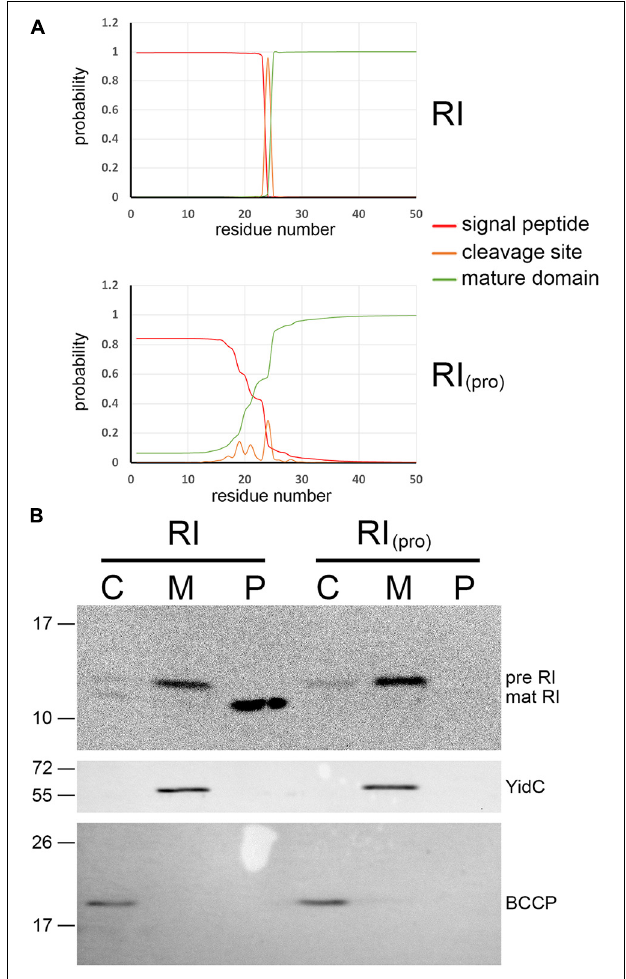
FIGURE 1 | The N-terminal domain of T4 antiholin RI constitutes a signal peptide with an expected signal peptidase cleavage site. (A) SignalP comparison of signal peptide from pinholin-associated endolysin P1 (the first identified SAR domain; Xu et al., 2004) with the signal peptide of the T4 antiholin RI. Note the distinct cleavage site likelihood. For more comparisons, see Supplementary Figure 1 . (B) Transport analysis of RI and a RIpro variant with an inactivated signal peptidase cleavage site (top blot), using subcellular fractionation and sodium dodecyl sulfate–polyacrylamide gel electrophoresis (SDS-PAGE)/Western blotting detection of the hemagglutinin (HA) tag at the C-terminus of RI. The bottom blots are controls that demonstrate no leakage of cytoplasm into the periplasmic fraction [biotin carboxyl carrier protein (BCCP), a cytoplasmic marker] and no leakage of cytoplasmic membranes into the periplasmic fraction (YidC control). C, cytoplasmic fraction; M, membrane fraction; P, periplasmic